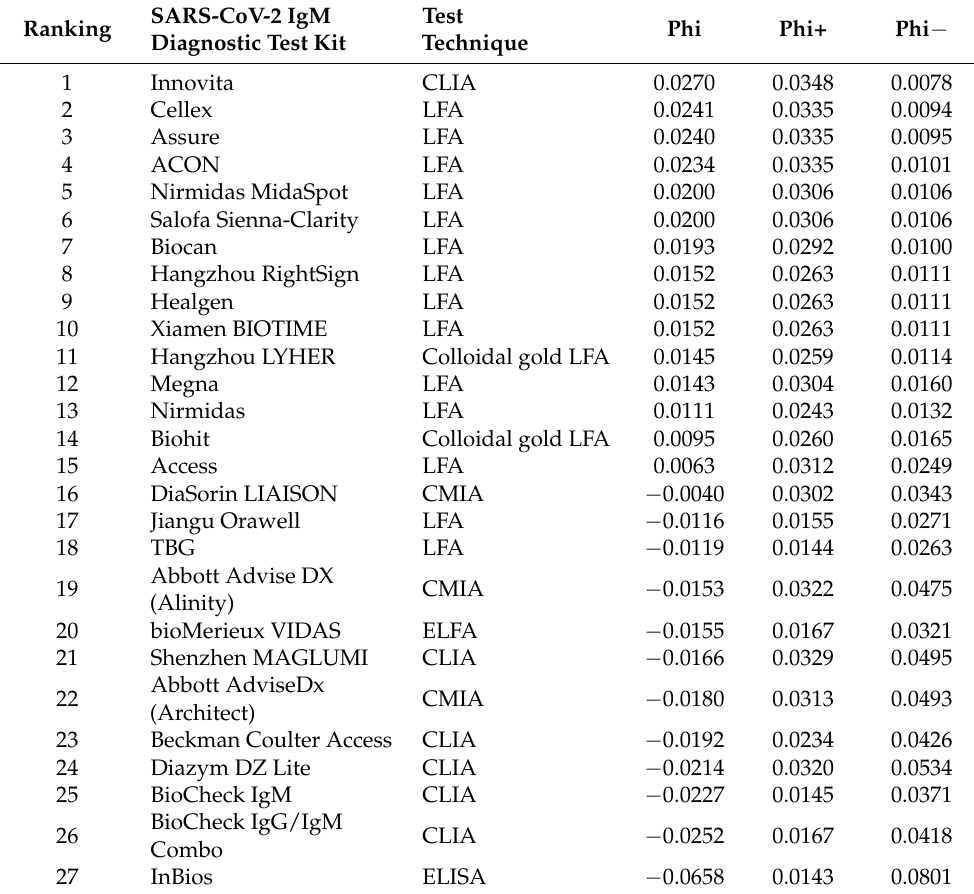
Table 2. Complete ranking of FDA EUAs SARS-CoV-2 IgM antibody